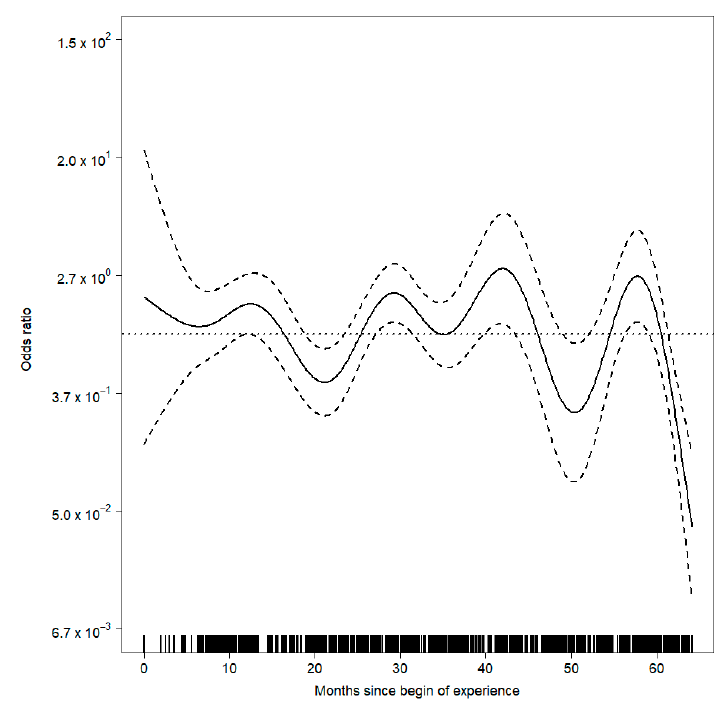
Figure 4. Multivariable association between requirement for additional hemodynamic support and patient and procedural characteristics. ( A ) Age (months) ( p = 0.31); ( B ) Weight (kg) ( p = 0.20); ( C ) Time since beginning of experience (months) ( p < 0.01).